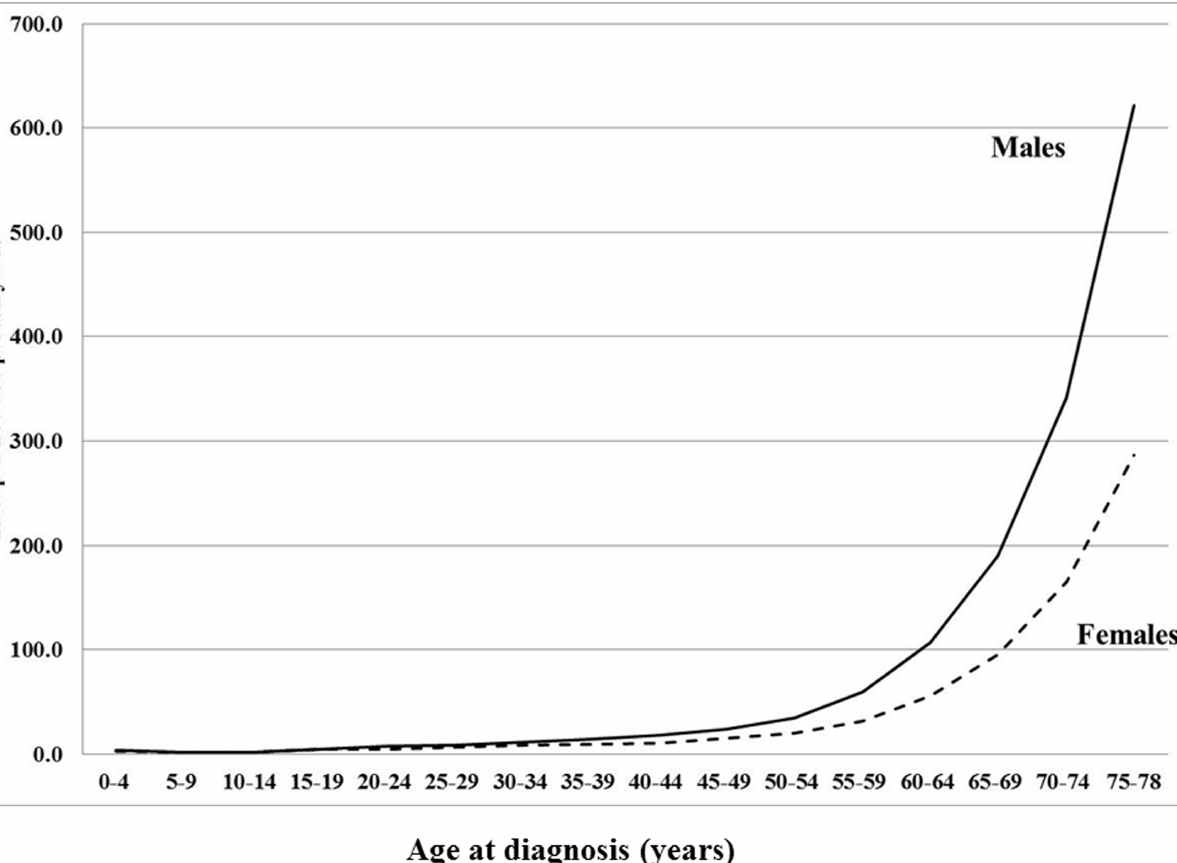
Figure 1. Age-specific incidence rates (per 100000 person years) of kidney failure for males and females in offspring/siblings born in 1932 and later.